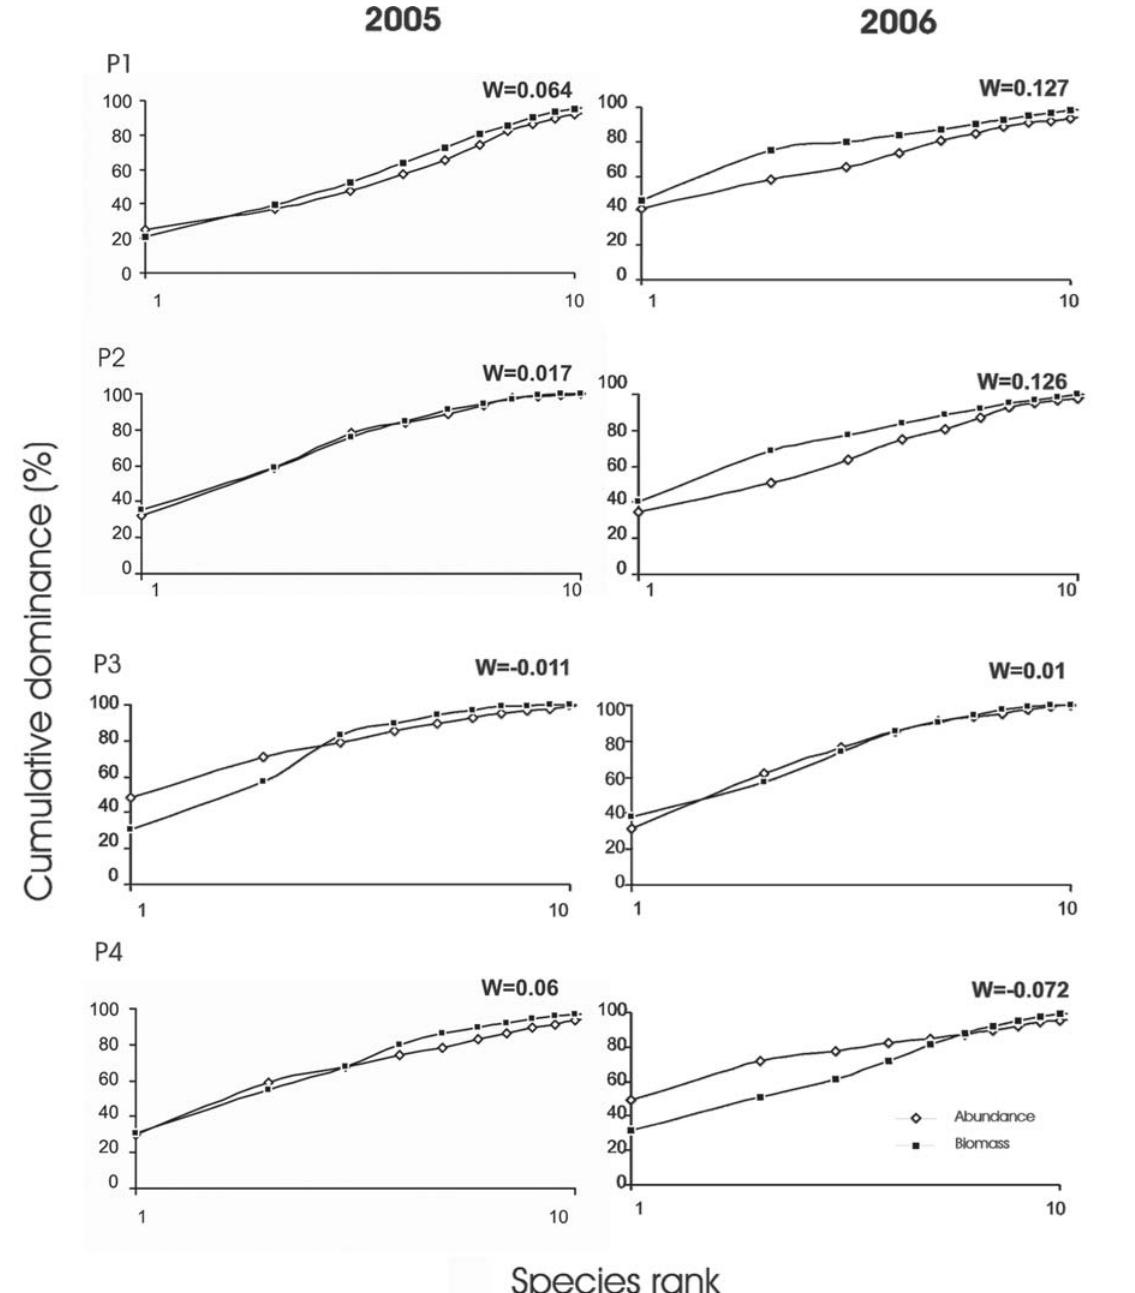
Fig. 4. ABC curves per year of fish assemblages from stream stretches located in preserved areas. P1 = Macaúba; P2 = Carapina; P3 = Barreiro; P4 = Cana Brava. W = statistical value for each